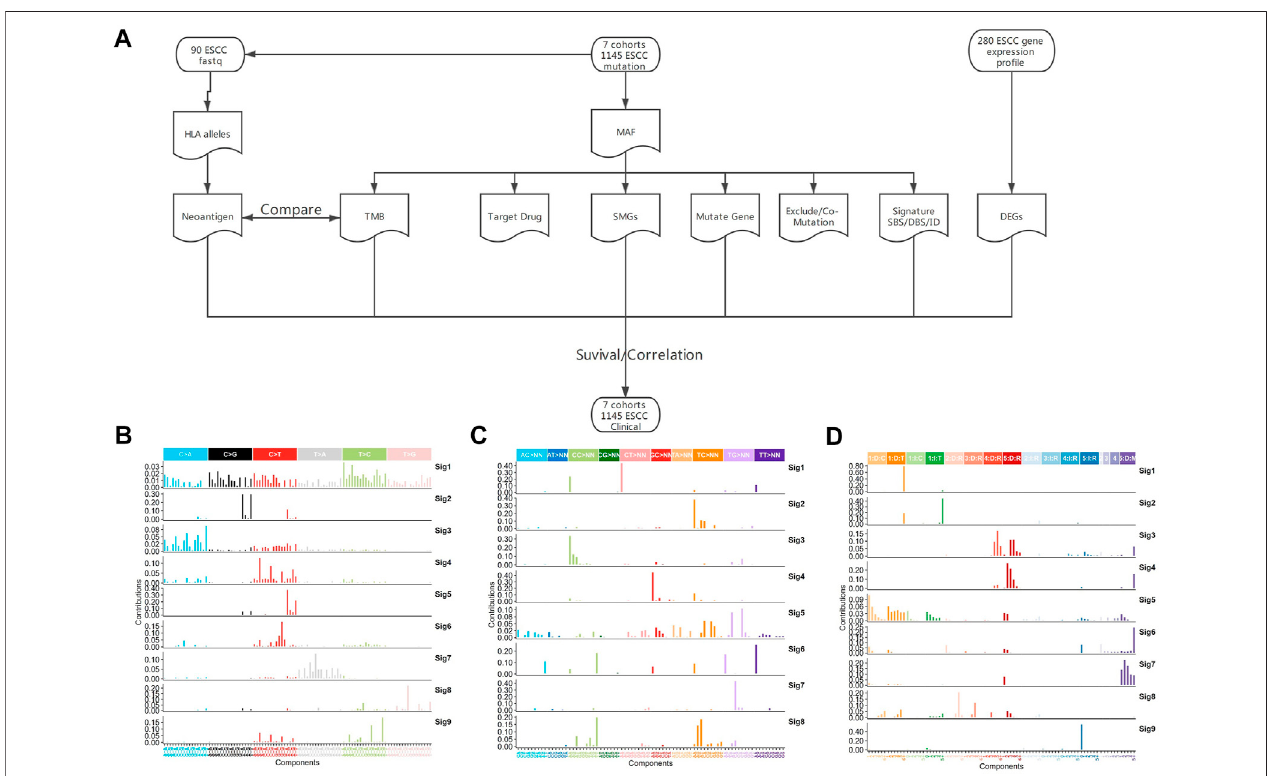
FIGURE1| AnalysispipelineandmutationsignatureofwholegenomeregioninESCC. (A) Analysispipeline, (B) SBSsignatureofWGS, (C) DBSsignatureofWGS, (D) ID signature of WGS.